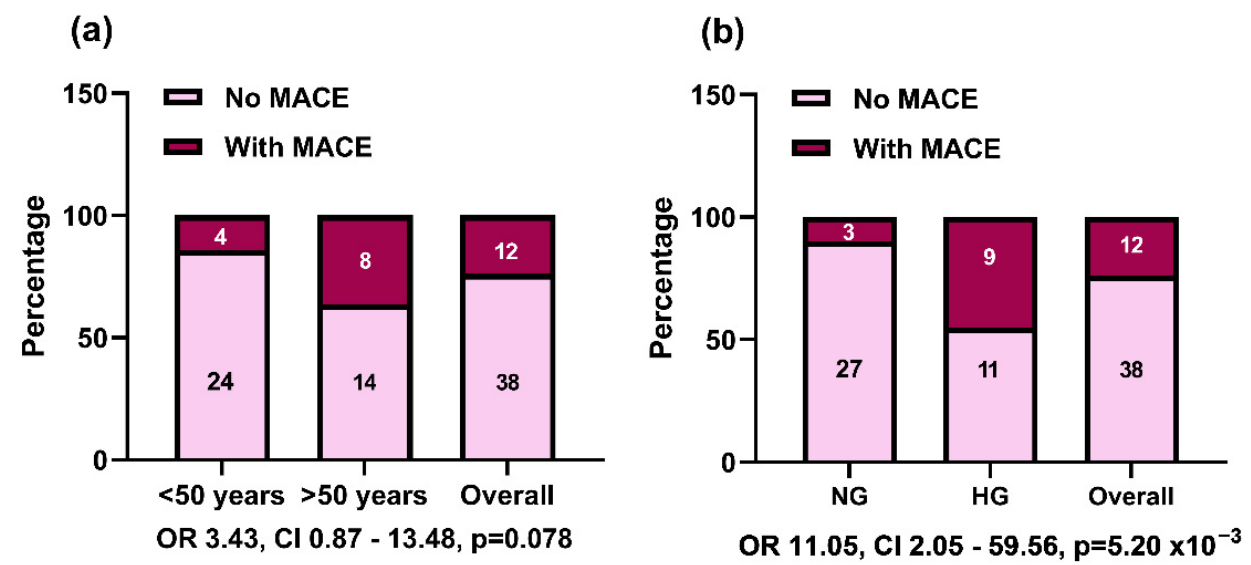
Data are given as mean ± SEM (for age) and as case numbers (and percent) for clinical features. Statistical differ- ence between groups was assessed either by independent Student’s t-test, Mann–Whitney U test (for continuous data age, LVEF), or Pearson χ 2 analysis for categorical data (clinical and angiographic data, cardiovascular risk factors). LVEF, left ventricle ejection fraction; LAD, left anterior descending artery; RCA, right coronary artery; LCX, left circumflex artery.